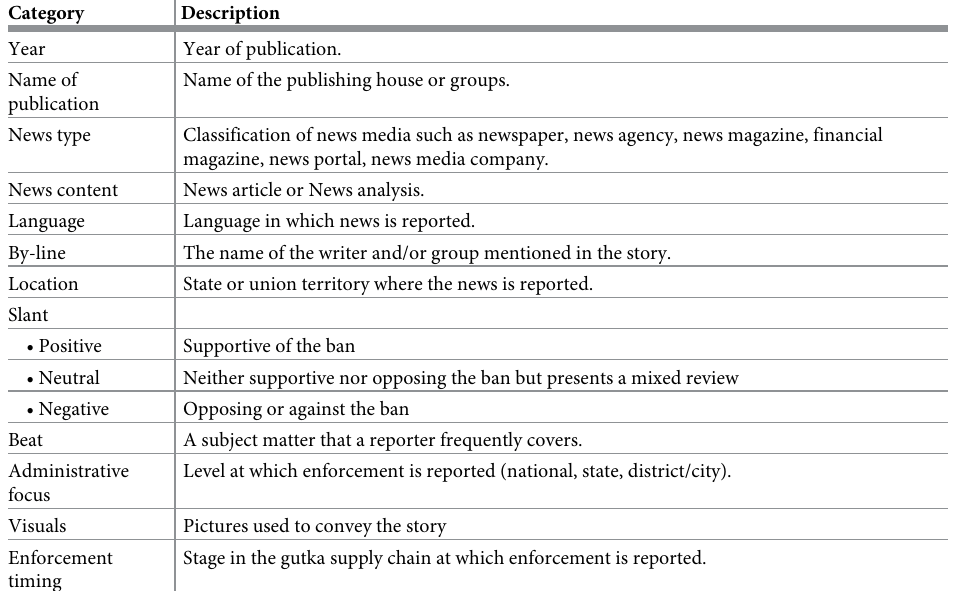
Table 1. Data extraction and coding